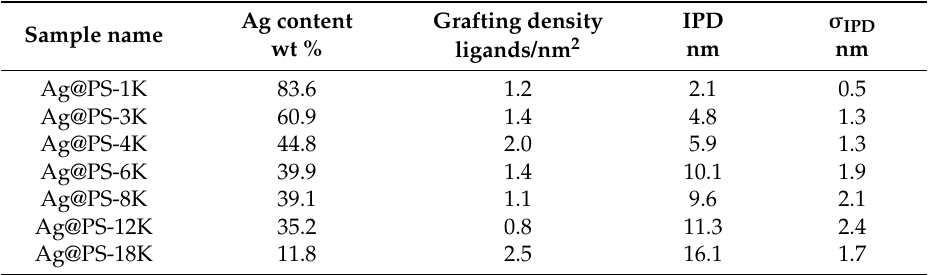
Table 2. Overview of the silver content, grafting density, and edge-to-edge interparticle distance (IPD with standard deviation σ IPD ) of the nanocomposite